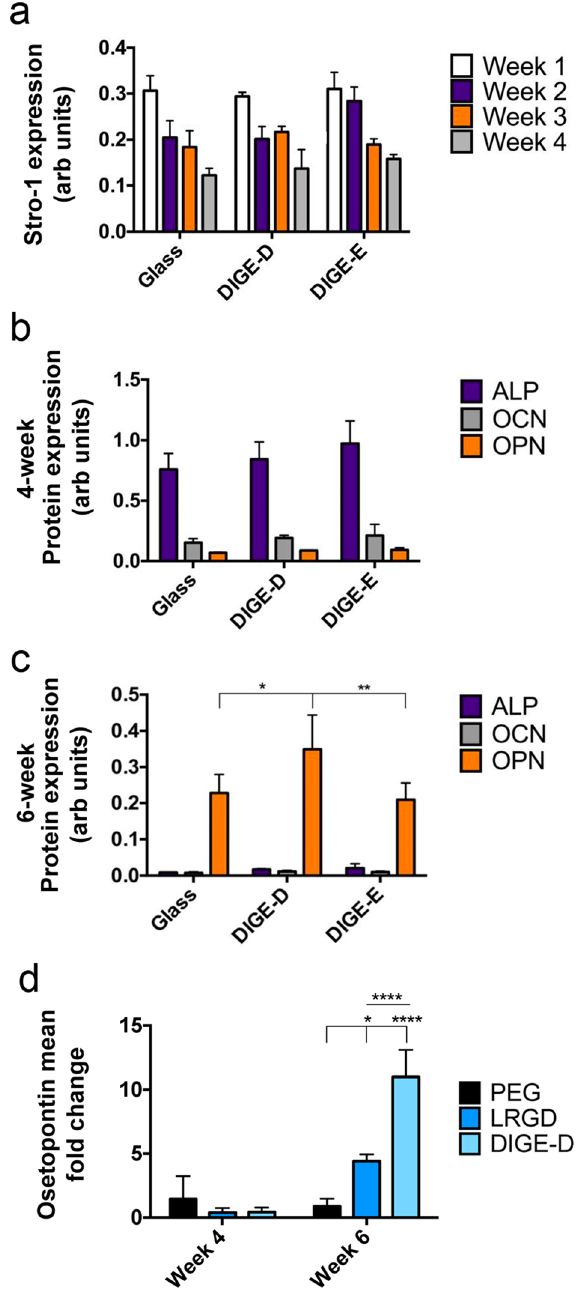
Figure 5. SSC phenotype on DIGE-D surface. ( a ) In cell western (ICW) data for Stro-1 showing no difference between SSCs cultured on glass control and DIGE-D and DIG-E surfaces showing that cells express similar levels of this SSC marker on the SPPS test and control surfaces when the RGD/RGE is hidden by the PEG blocking group. ( b,c ) ICW data for alkaline phosphatase (ALP), osteopontin (OPN) and osteocalcin (OCN) after 4 weeks ( b ) and 6 weeks ( c ) of culture. No differences were noted between samples at 4 weeks, but at 6 weeks, higher levels of OCN expression were noted in SSCs on the DIGE-D surface. ( d ) QPCR for OPN transcripts after 4 and 6 weeks of MSC culture on PEG, LRGD and DIGE-D surfaces. At 4 weeks no change was seen. However, at 6 weeks, the DIGE-D MMP-responsive surface supported significantly greater OPN expression. Graphs show mean ± SD, n = 3, statistics by ANOVA and Tukey test where *p < 0.05, **p < 0.01, ***p < 0.001 and ****p < 0.0001. If stars are not shown on the graphs, it denotes no significant difference was observed between the treatment and relevant